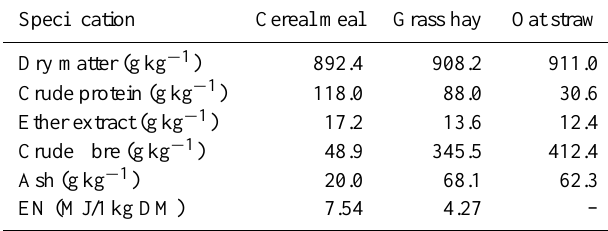
Table 1. The chemical composition of feeds used in nutrition of examined ewes.